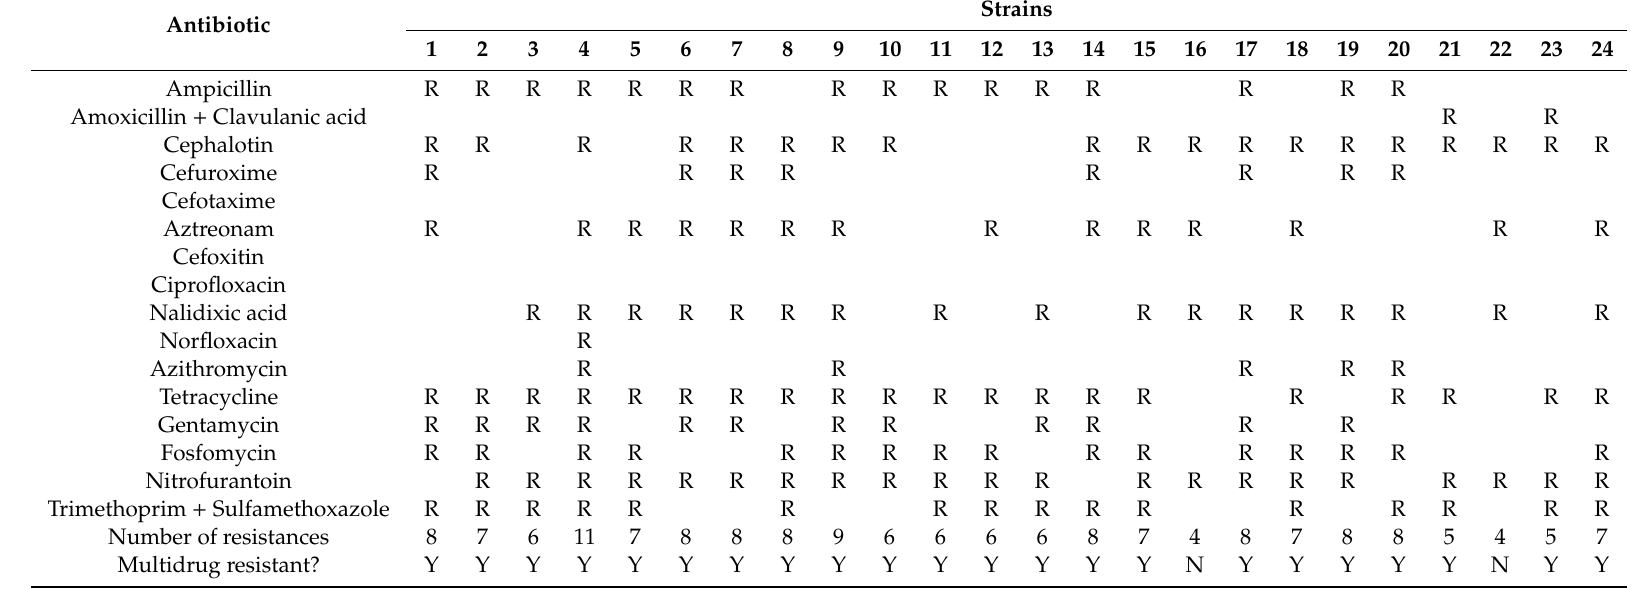
Table 2. Resistance profile of the tested clinical strains of uropathogenic Escherichia coli to various antibiotics. Antibiotic